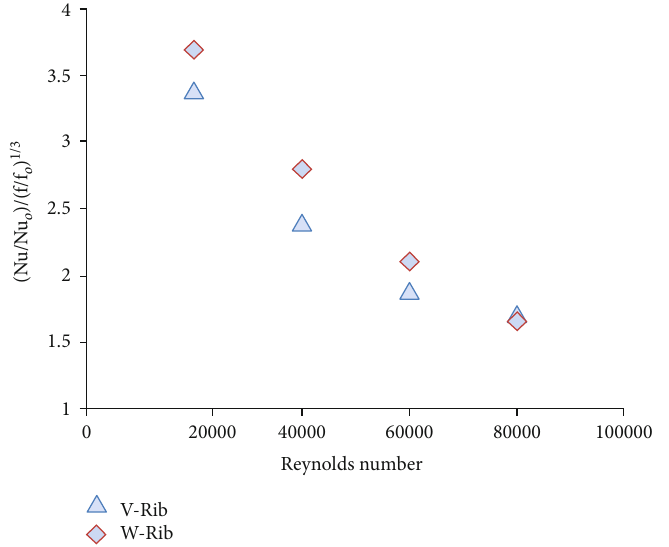
Figure 11: Thermohydraulic performance. Table 3: Nu/Nu o